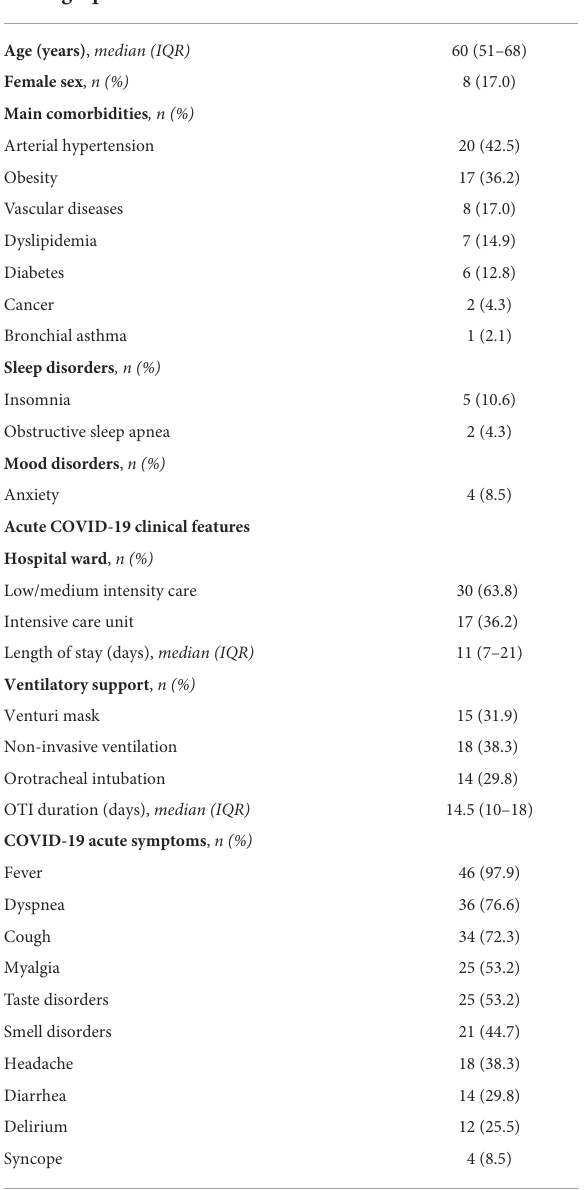
TABLE 1 Main demographic and clinical characteristics of study sample at baseline.